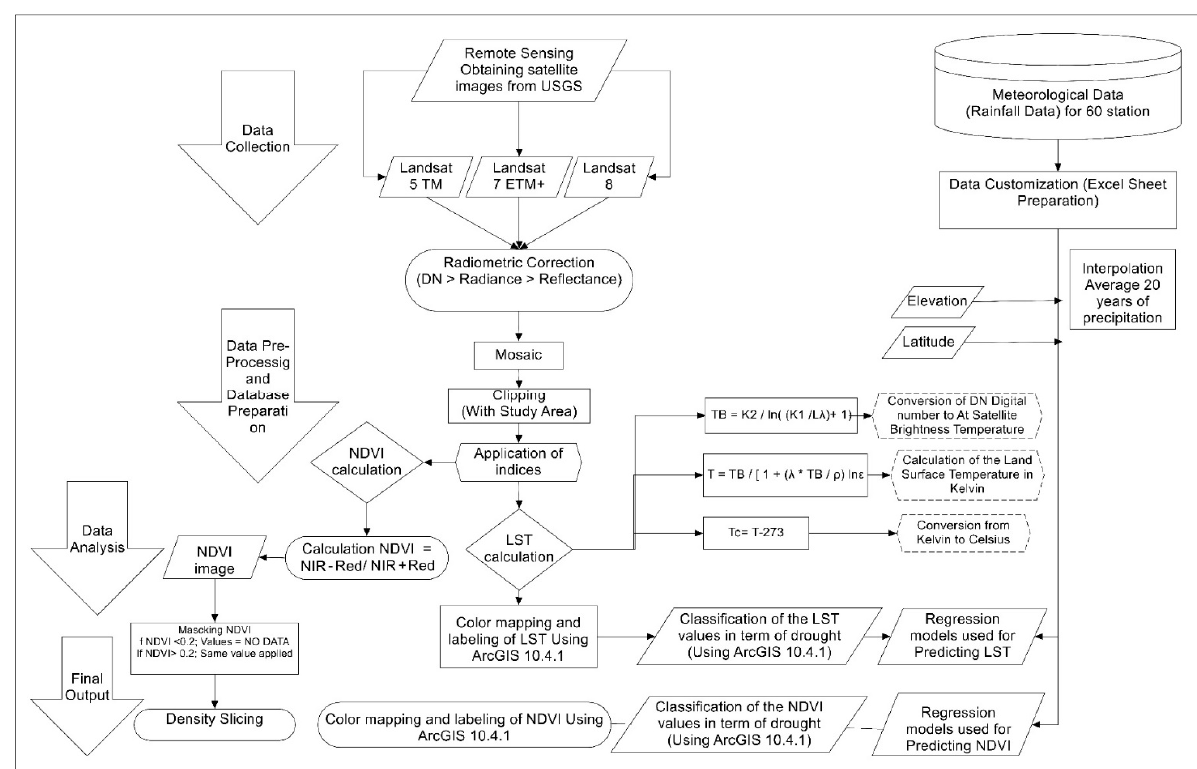
Figure 3. Flowchart of the methodology adopted in this study.